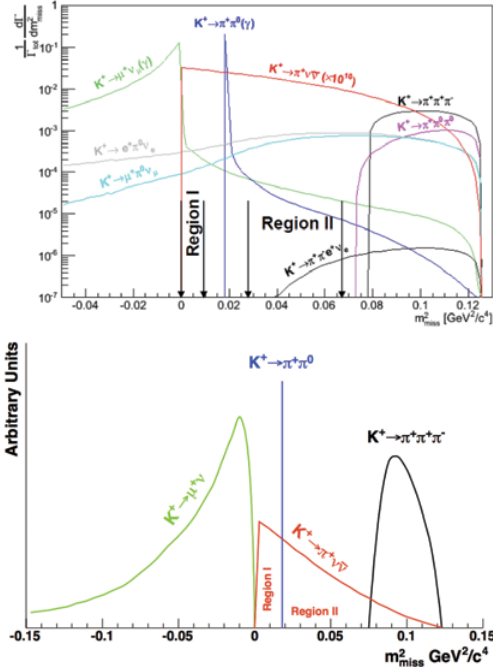
Figure 3. Top: Distribution of m 2 miss for the signal and the main background sources after kinematic cuts. Bottom: Distribution of m 2 miss for the main kaon decays and the signal, with the hy- pothesis that the charged decay product is a pion. The two signal regions, [0 , 0 . 01] GeV 2 / c 4 and [0 . 026 , 0 . 068] GeV 2 / c 4 , are indi- cated.